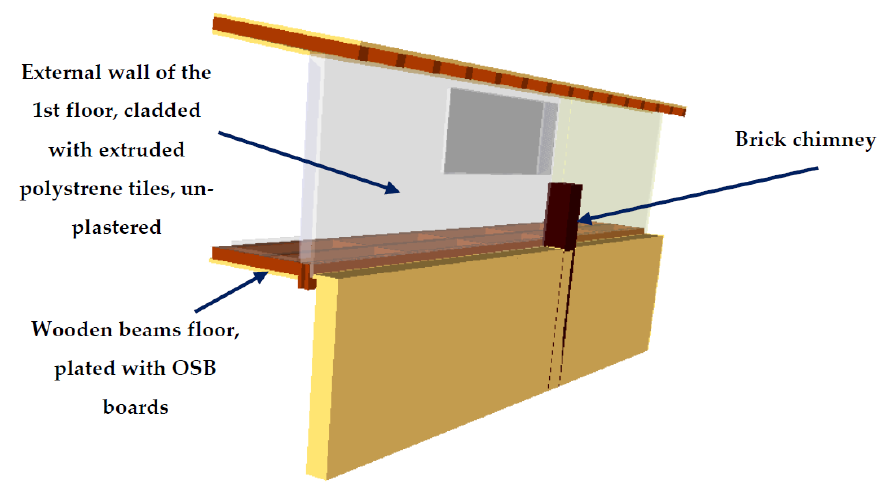
Figure 4. Building section (ground floor and first floor), eastern wall. Hypothesis (2).